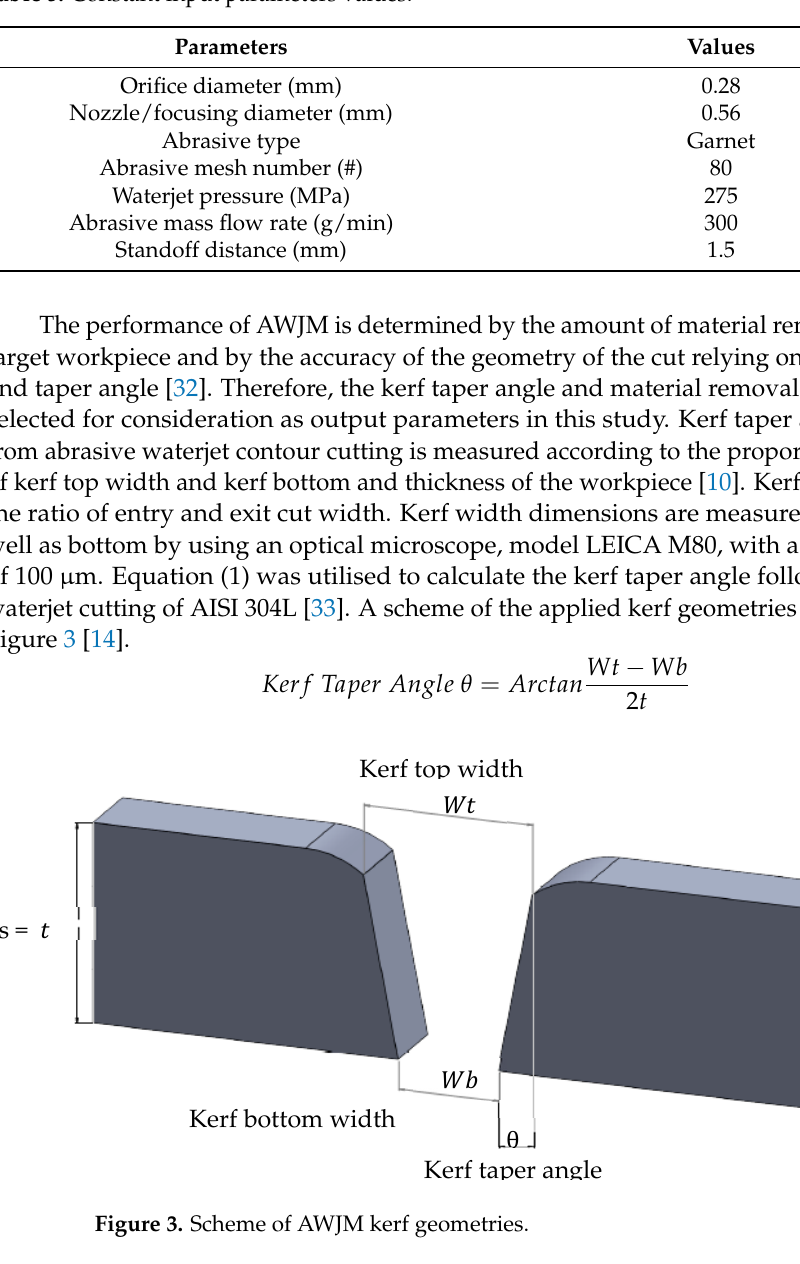
Table 5. Constant input parameters values.